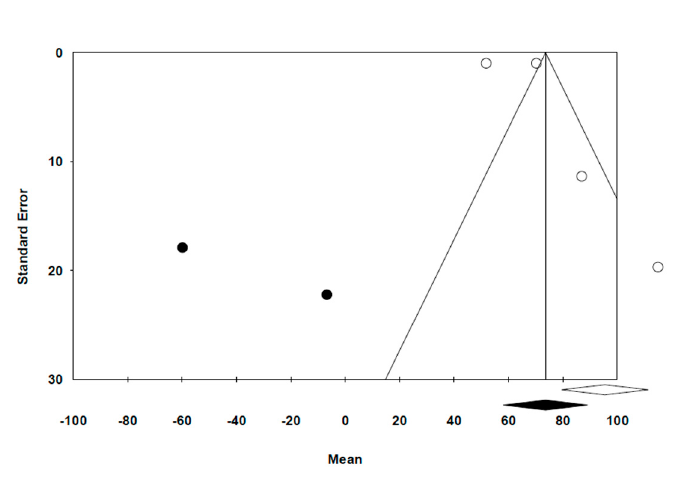
Figure 4. Funnel Plot with trim and fill (Duval and Tweedie).